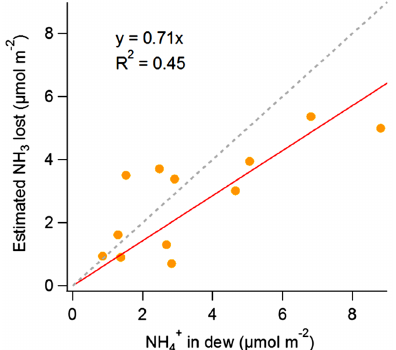
Figure 5. Estimated NH 3 lost overnight assuming a 150m bound- ary layer vs. measured NH + accumulated in dew by the onset of 4 evaporation. The red line is the best fit line (forced through the ori- gin) and the dashed grey line is the 1:1